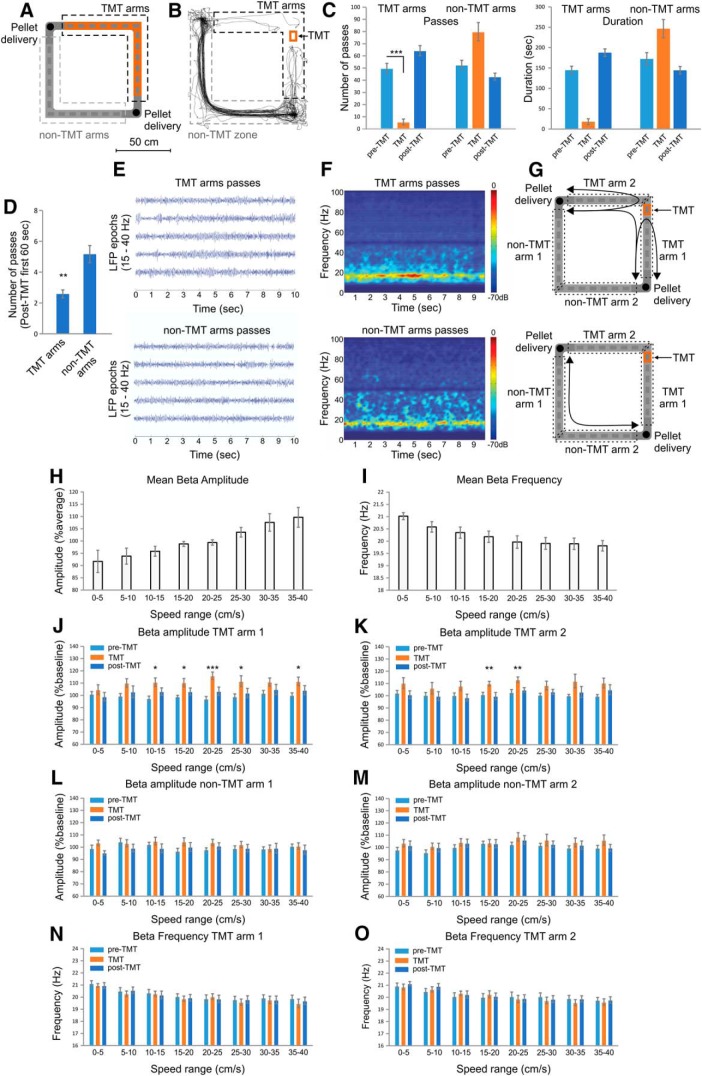
Increase in hippocampal β activity during odor-triggered place avoidance. A, Setup of the rectangular-shaped linear track. Locations of the TMT are marked with red in the NE arms of the track. The black dashed line indicates the TMT arms, while grey dashed line marks the non-TMT arms. To match the TMT protocol with the subsequent ChR2 photostimulation protocol, we applied TMT scent papers to different locations in both TMT arms. B, Representative navigation path of a rat during the TMT session. Note the place avoidance of the TMT arms. C, Number of passes (left graph) and duration in seconds (right graph) in the TMT and non-TMT arms during the pre-TMT, TMT, and post-TMT sessions; ***p < 0.001. Error bars, mean ± SEM. D, Number of passes through the TMT and non-TMT arms for the first 60 s of the post-TMT session; **p < 0.01. E, Representative bandpass-filtered (15–40 Hz) LFP traces recorded during the passes in the TMT arms (top panel) and in the non-TMT arms (bottom panel). Time 0 indicates the start of the path trajectory from the pellet delivery location. F, Representative averaged bandpass-filtered (15–40 Hz) color-coded power spectrogram of all passes in the TMT arms (top panel) and in the non-TMT arms (bottom panel). The averaged power spectrogram includes the variability of pass duration and speed during the navigation across the arms. G, Spatial dissociation of odor perception for TMT arms (top panel) and non-TMT arms (bottom panel). The arm with TMT scent paper was named TMT arm 1. The adjacent arm, part of the same food-navigation loop, was TMT arm 2. The opposite of TMT arm 1 was named non-TMT arm 1, while the opposite of TMT arm 2 was non-TMT arm 2. The scent was detected by the animal at different locations during the navigation passes across the TMT arms. Black arrows indicate the possible path trajectories of the animals. Mean β amplitude (H) and mean β frequency (I) measured for rats with a whole-body speed of 0–40 cm/s, in bins of 5 cm/s. J, β Amplitude for TMT arm 1 and K TMT arm 2 (right) as percentages of the pre-TMT session values for the entire track; ***p < 0.001, **p < 0.01, *p < 0.05. Error bars, mean ± SEM. β Amplitude for non-TMT arm 1 (L) and non-TMT arm 2 (M) as percent of the pre-TMT session values for the entire track. The amplitude values are presented as a function of the animal’s whole-body speed, where β amplitude is evaluated for a speed range of 0–40 cm/s in bins of 5 cm/s. Error bars, mean ± SEM. β Frequency for TMT arm 1 (N) and TMT arm 2 (O) for speed range of 0–40 cm/s in bins of 5 cm/s. Error bars, mean ± SEM.